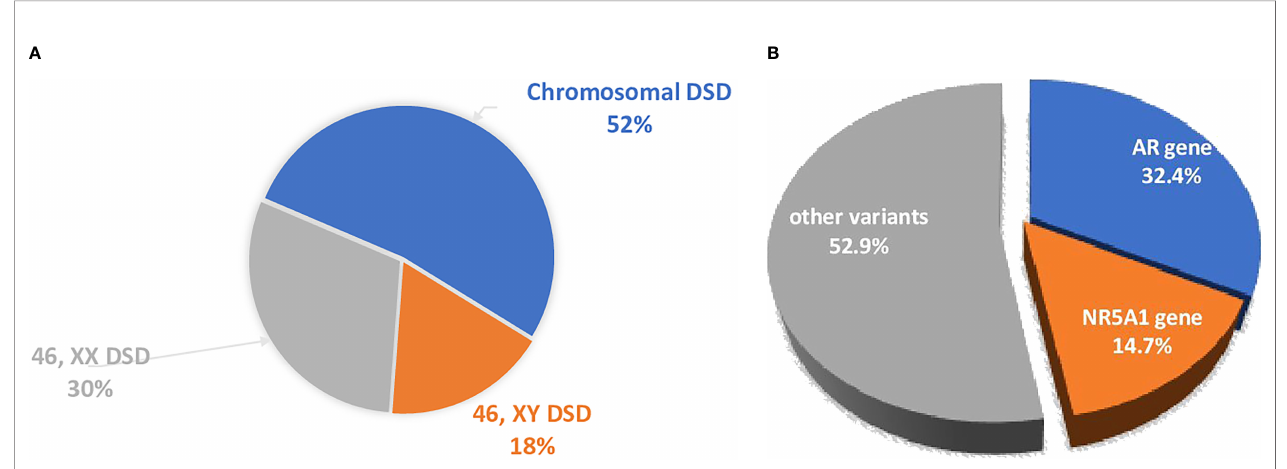
FIGURE 1 | (A) The distribution of the different forms of DSD in the Ukrainian DSD registry. 46,XX DSD cohort included 89.8% CAH patients. (B) The distribution of the main genetic causes of DSD were analyzed by WES. The dominant causes are due to variants in the AR and NR5A1